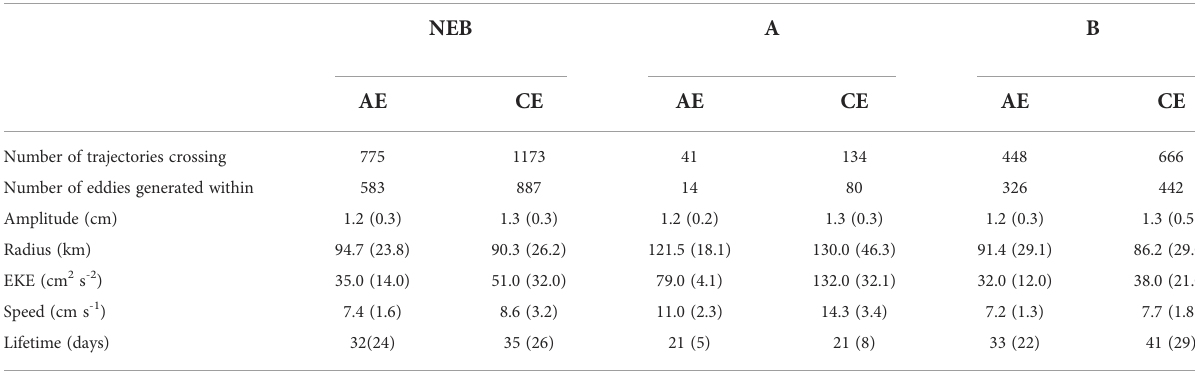
TABLE 1 Mean properties and characteristics of AE and CE within NEB and northern part of NEB (A) and southern part of NEB (B). Mean (STD)